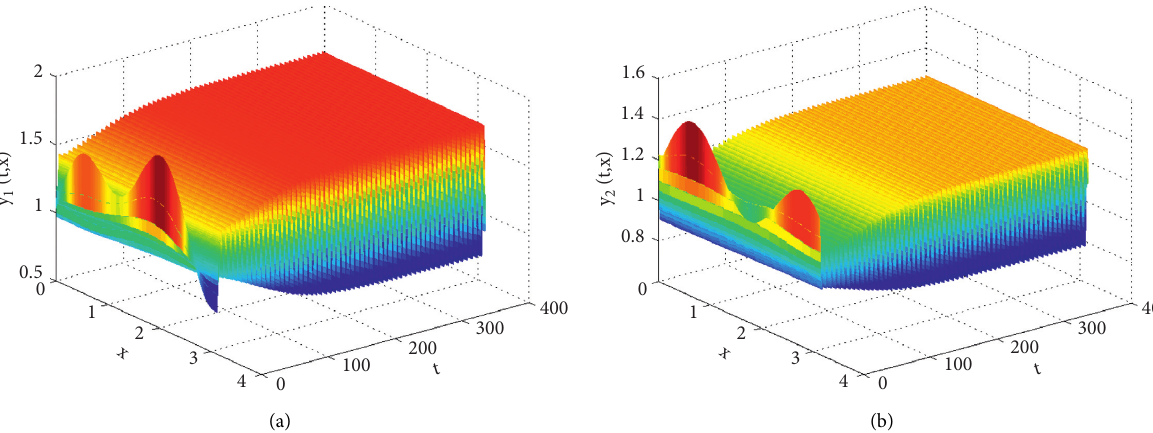
Figure 3: The positive constant steady state of the system with Neumann boundary loses its stability, and Hopf bifurcation occurs for � 0 . 9, τ � 1 . 5, and τ � τ τ 1 2